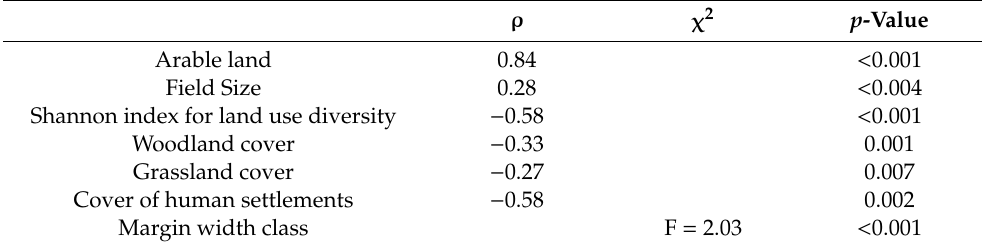
Table 2. Correlations of PCA first axis (PC1) with the landscape and local variables selected as proxies of the intensity of management in field margins. Spearman’s rank correlations ( ρ ) were used except for margin width class, for which the correlation with PC1 was determined by the Kruskal–Wallis ( χ 2 ) test. ρ χ 2 p